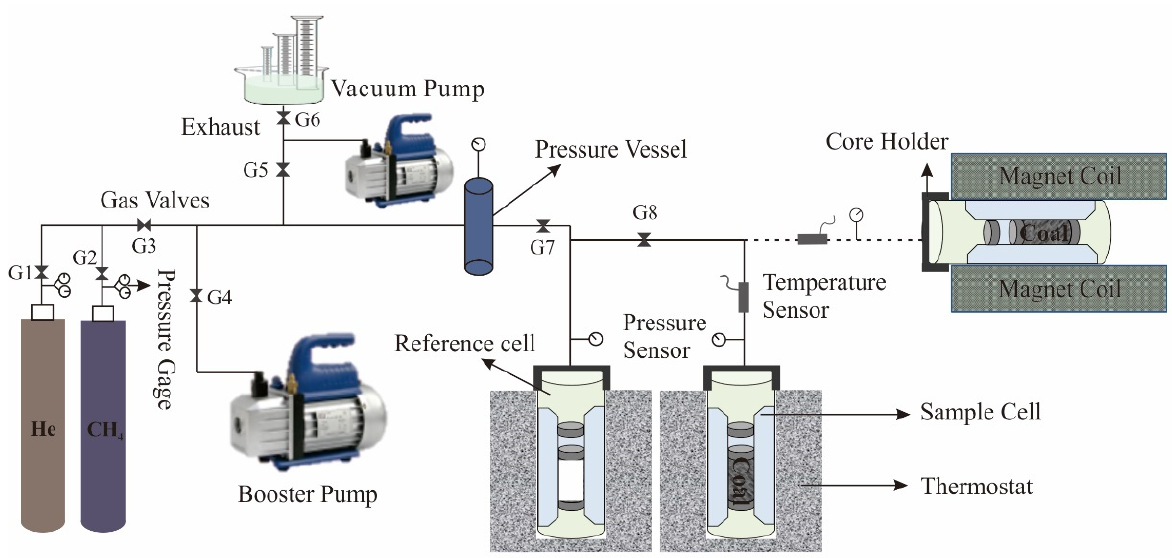
Figure 2. Schematic diagram of the NMR methane adsorption experimental